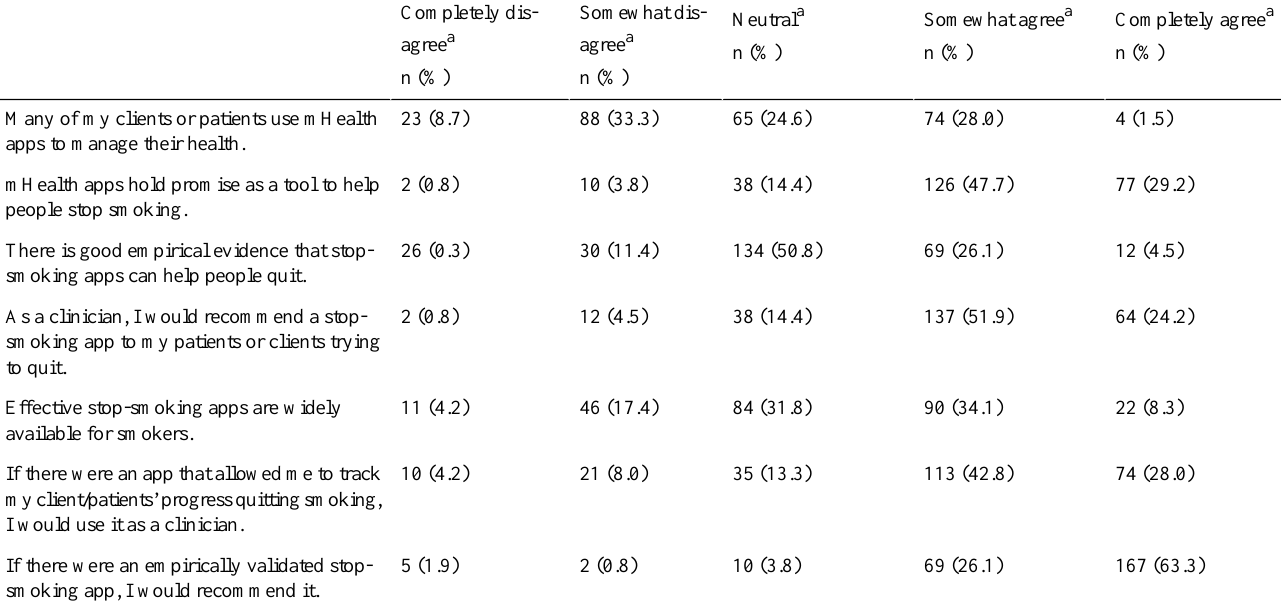
Table 1. Provider attitudes and beliefs about smoking cessation apps (N=264).